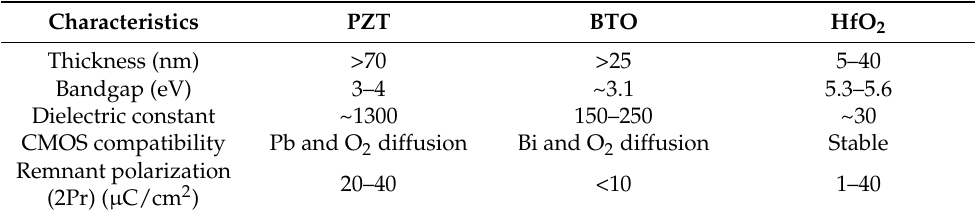
Table 1. Comparison of material properties and scalability between HfO 2 , PZT (lead zirconate titanate), and BTO (barium titanate).